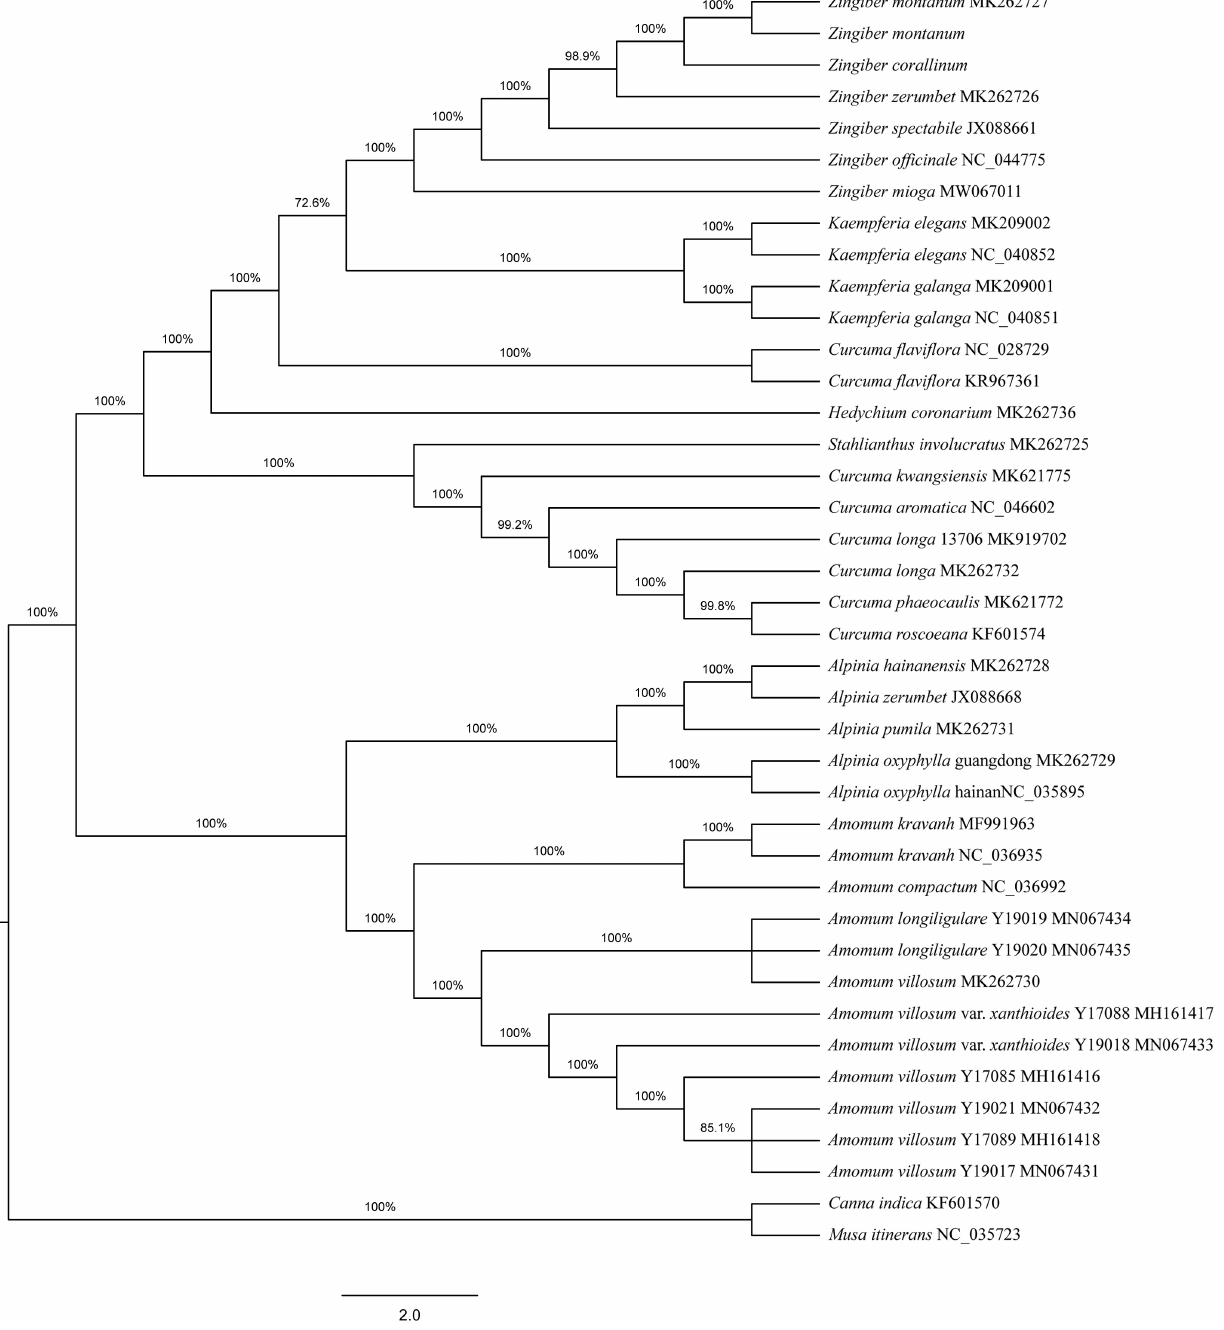
Figure 4A . The two Zingiber Species could be separated clearly by a supervised OPLS-DA ( Figure 4B ). The R 2 X, R 2 Y, and Q 2 of this model were 0.747, 0.947, and 0.924, respectively. The 200-permutation test (R 2 intercept 0.214 and Q 2 intercept − 0.504) validated the stability and reliability of this